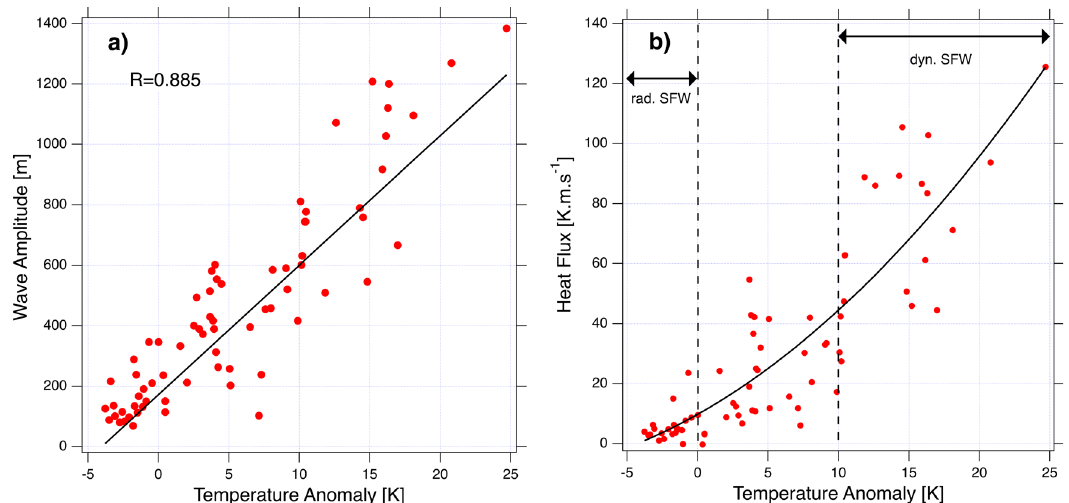
Fig. 2 FSW wave amplitude, heat fl ux and temperature anomaly. a Amplitude of geopotential wave 1 at 60°N-10 hPa versus fi nal warming temperature anomaly and linear fi t. The black line represents the linear regression (correlation coef fi cient R = 0.885). b Zonal-mean heat fl ux at 60°N-10 hPa versus temperature anomaly. The black line represents the parabolic fi t.